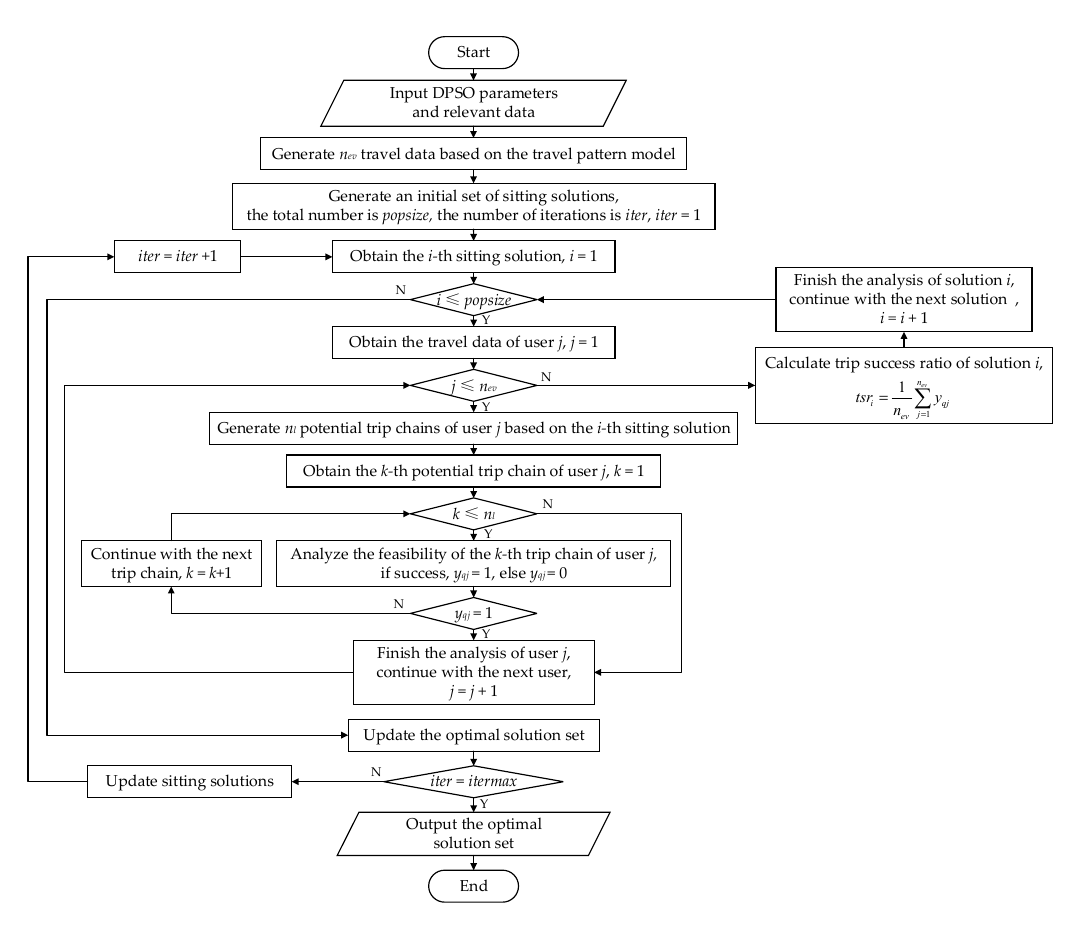
Figure 9. The flowchart of the upper model.